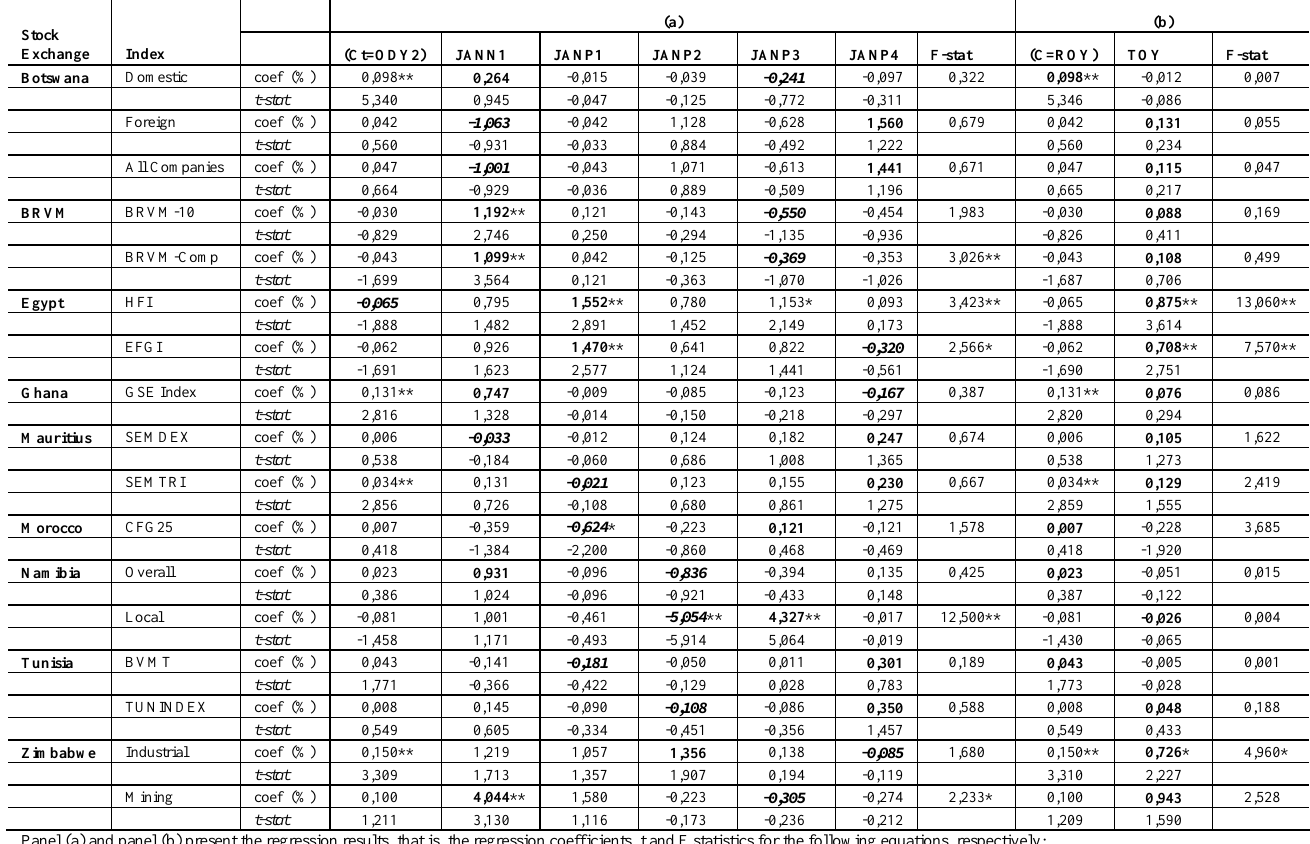
Table 4: Regression results for end/turn-of-the-year effect